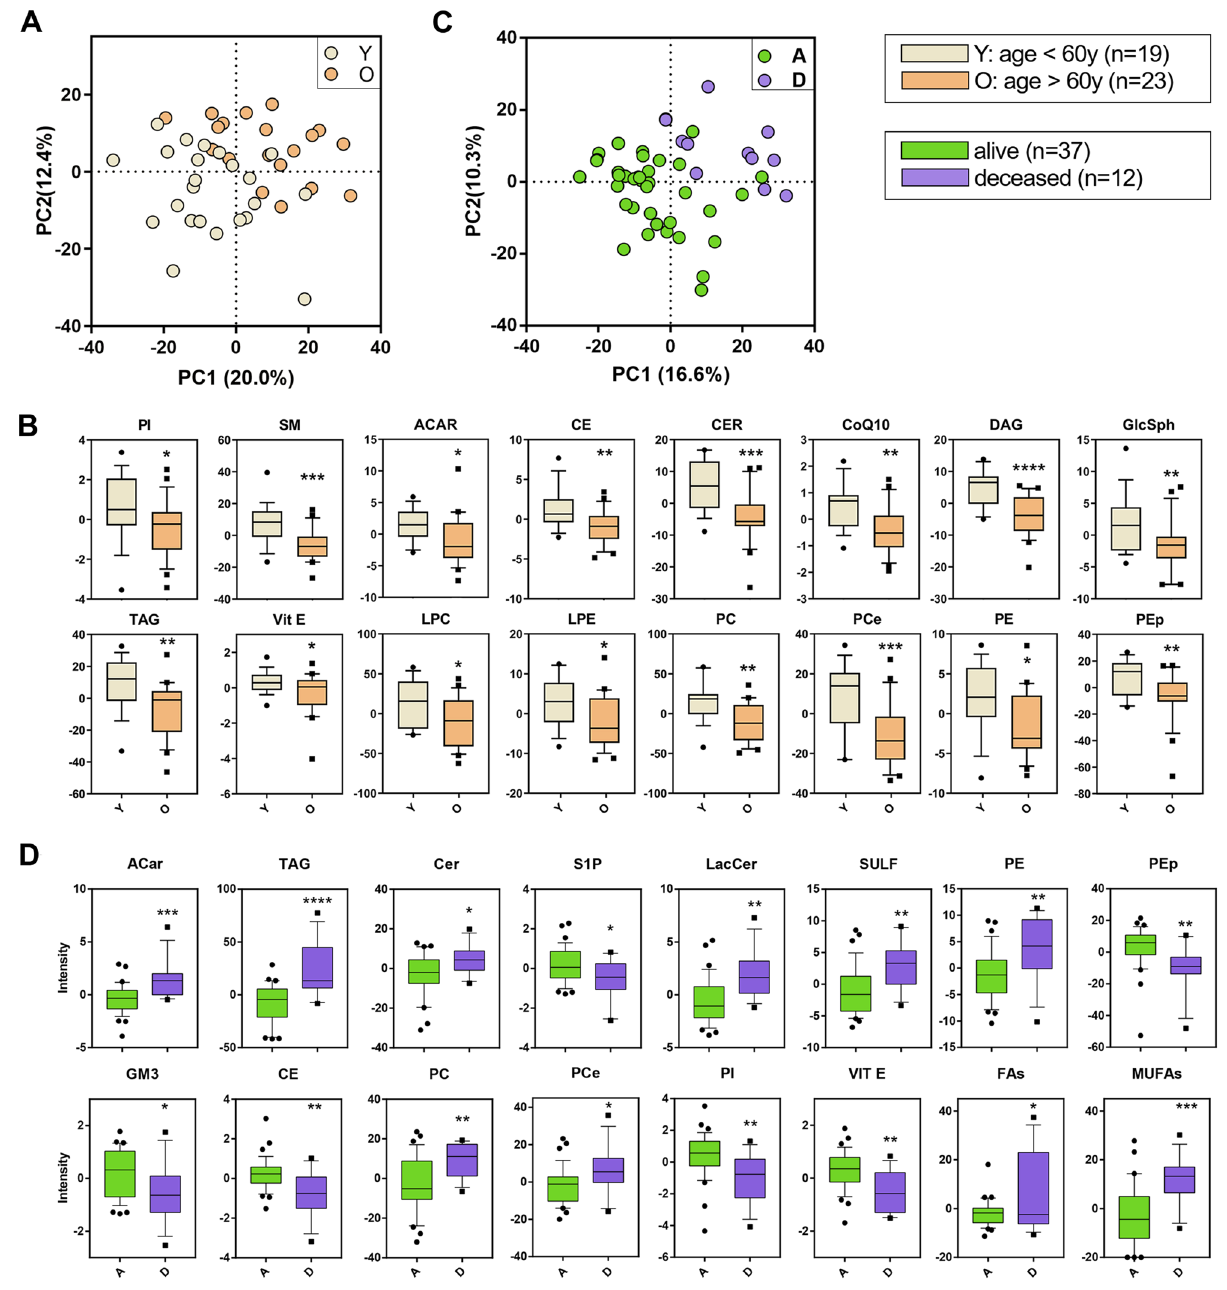
Figure 3. Discriminant analysis (score plot) of the lipidome as a function of age ( A ) and outcome ( C ). Only lipid classes with a statistical significance in the groups of each clusterization are shown in boxplots: age in ( B ) and outcome in ( D ). Boxes: 25th–75th percentiles; lines: 10th–90th percentiles; crossing lines: median values; separate points: outliers. Statistical significance: univariate